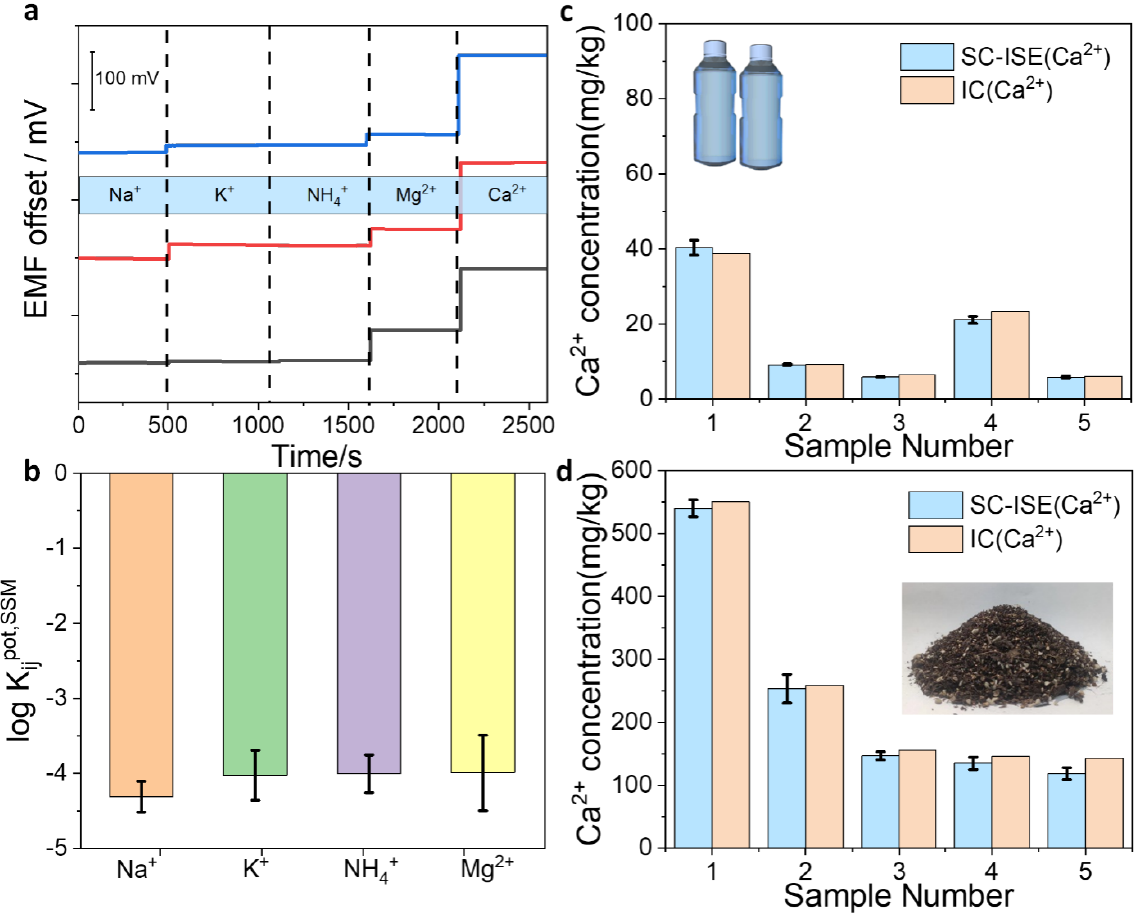
Figure 5. Calcium detection in real samples. ( a ) Potential measurements at a concentration of 0.1 M for other interfering ions (Na + , K + , NH 4+ , Mg 2+ ) and target ion (Ca 2+ ) by three individual measurements which are presented in different colors. ( b ) Selectivity coefficients obtained via the separation solution method. ( c ) Calcium-ion detection in mineral water and ( d ) soil-leaching solutions via the SC-ISEs and Ion Chromatography (IC).